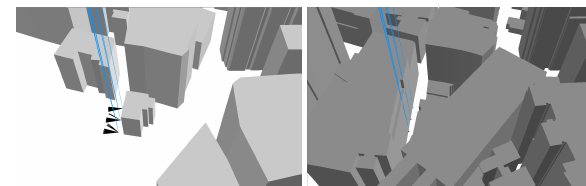
Figure 7: Maximum Variation between OSMM Max and OSM Max heights showing OSM (left) and OSMM (right) with the blue rays representing the elevations for the OSMM Max height data, and the black for the OSM Max data Table 4: Variation in Elevation - Wide Street (Leadenhall, Area A) versus Narrow Alleyway (Fenchurch Buildings, Area B)